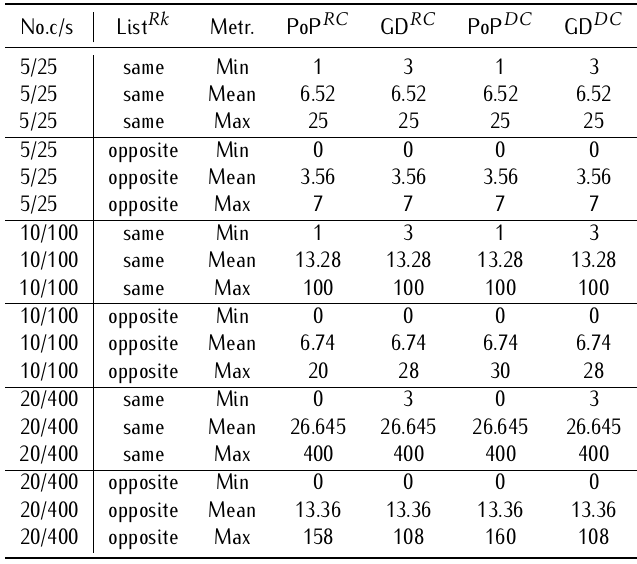
Table 3. Minimum (Min), Maximum (Max) and average (Mean) number of potential RDVs per cycle for gQS schemes in slot synchronized CRNs; No.c/s stands for Number of channels / slots; List Rk is the channel ranking lists